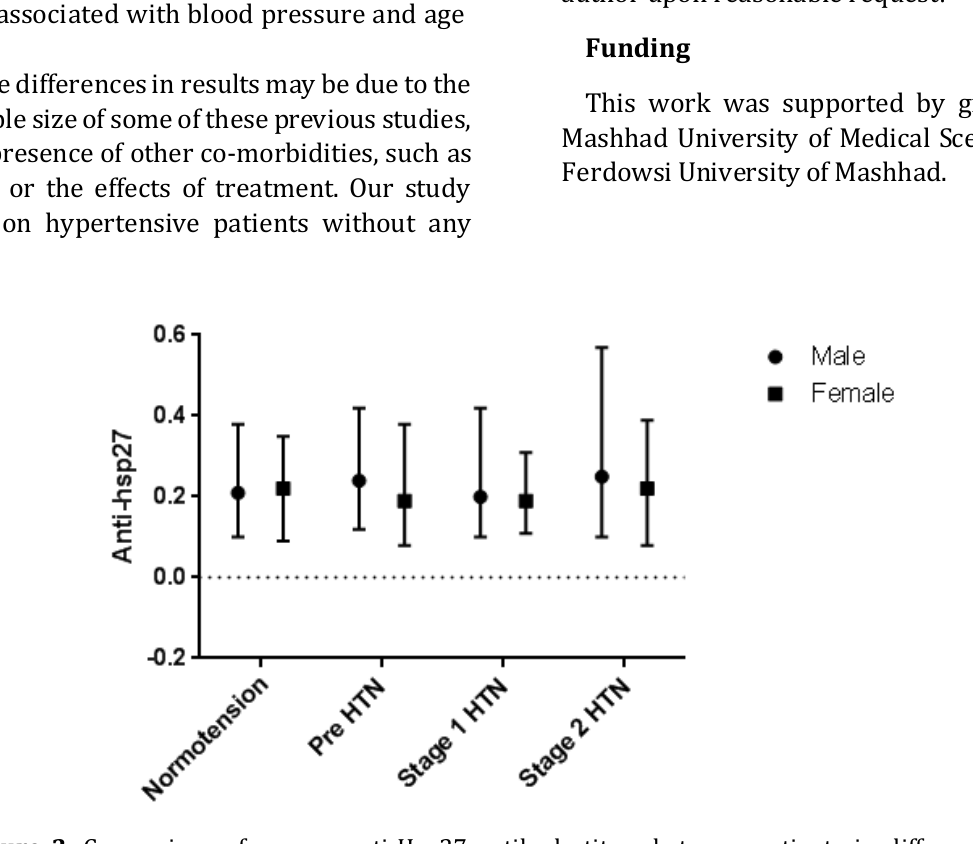
Figure 2. Comparison of serum anti-Hsp27 antibody titers between patients in different stages of hypertention